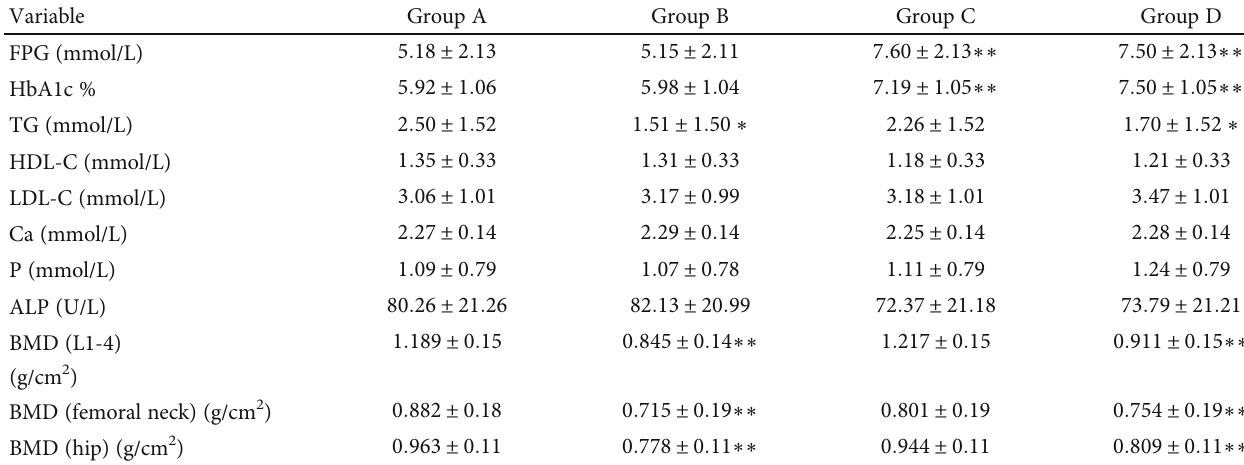
Table 2: Comparison of biochemical indices among groups after ANCOVA analysis ( − x ± s ).